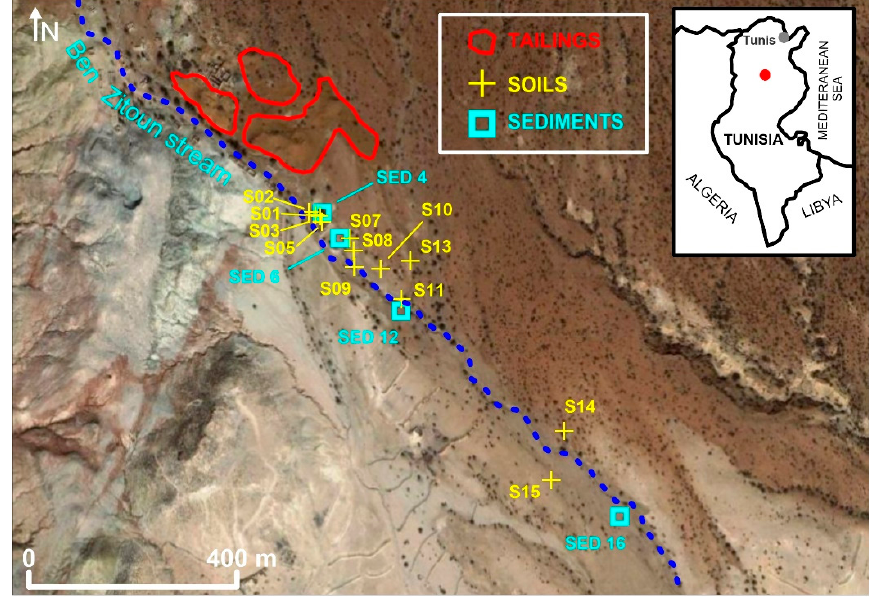
Figure 1. Locations of the study area (insert) and sampling sites. The source areas (tailings) are